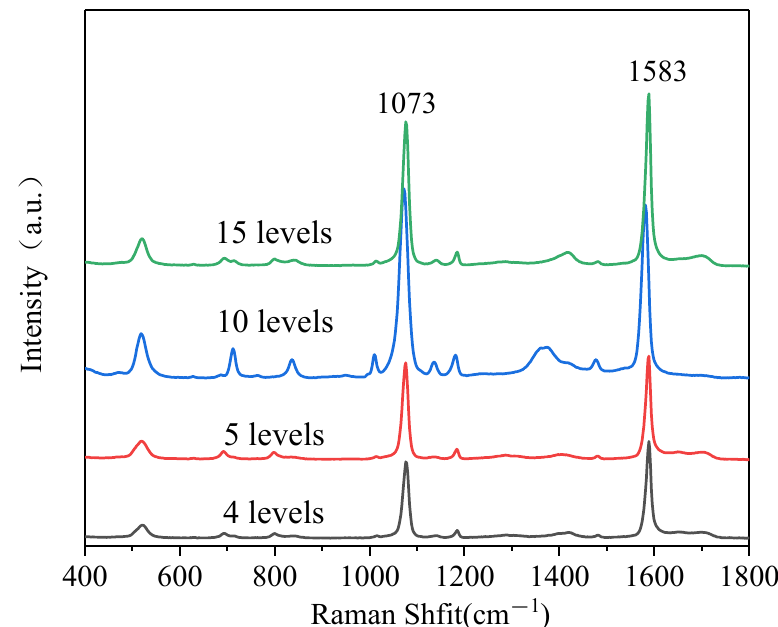
Figure 4. Raman spectra of MBA (100 ppm) on 2D PS/Ag with different layers. Portable Raman spectrometer, laser λ = 785 nm, acquisition time: 2 s.